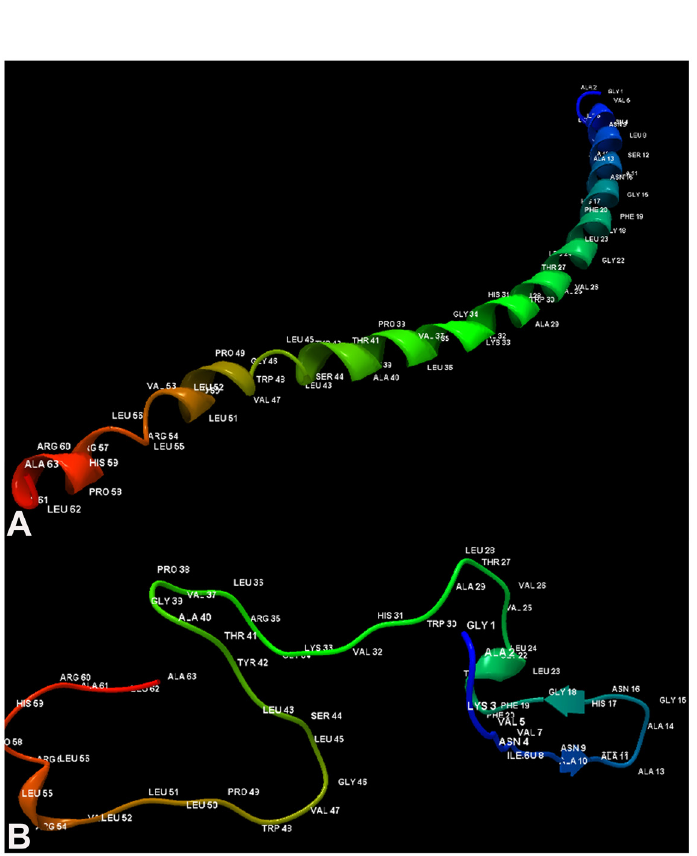
Fig 5. The 3D structure of both the modeled GT3 p7 and GT4 p7. (A) Coiled ribbon like structure of 63 amino acids p7 GT3 (b) Thread like structure of modeled p7 from GT4.